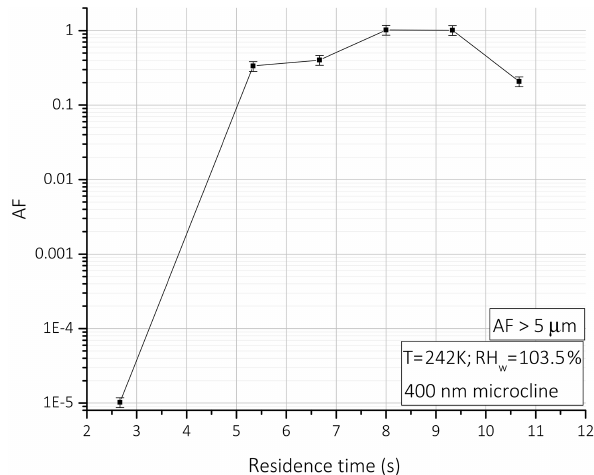
Figure A1. AF as function of residence time for 400nm microcline particles at 242K and RH w = 104%; data are the average over a to- tal of three experiments at each residence